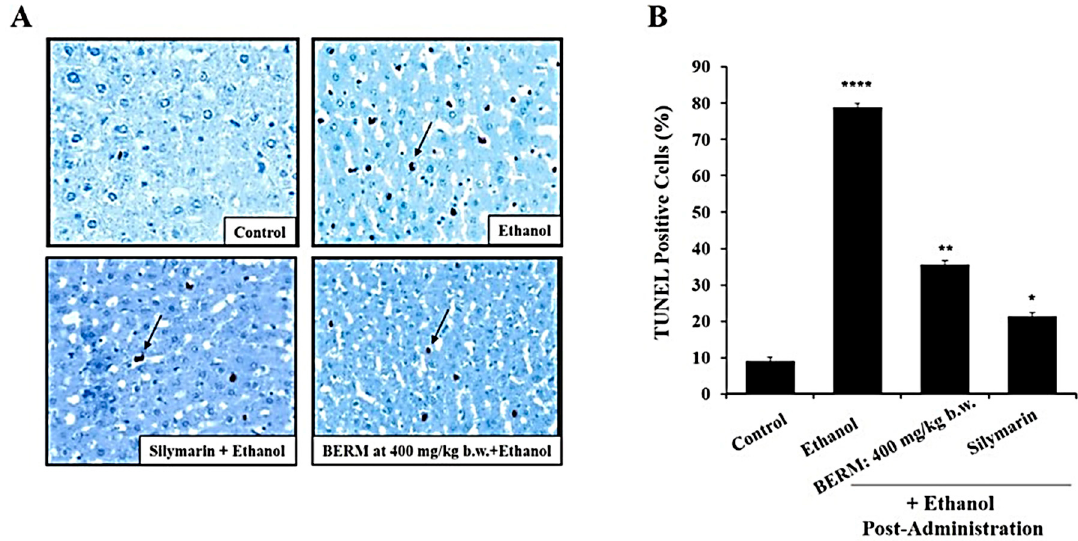
Figure 3. BERM pre-administration decreased ethanol-induced programmed cell death. ( A ) Rep- resentative photomicrographs showing apoptotic DNA fragments containing digoxigenin-labeled nucleotides were revealed using the TUNEL assay. The arrows point at examples of brownish apop- totic cells. ( B ) The bar shows the percentage TUNEL-positive apoptotic cells. The results are pre- sented as the mean ± SEM based on three independent experiments. * p < 0.05, ** p < 0.01, and **** p < 0.0001 signify a statistically significant difference compared with the control.